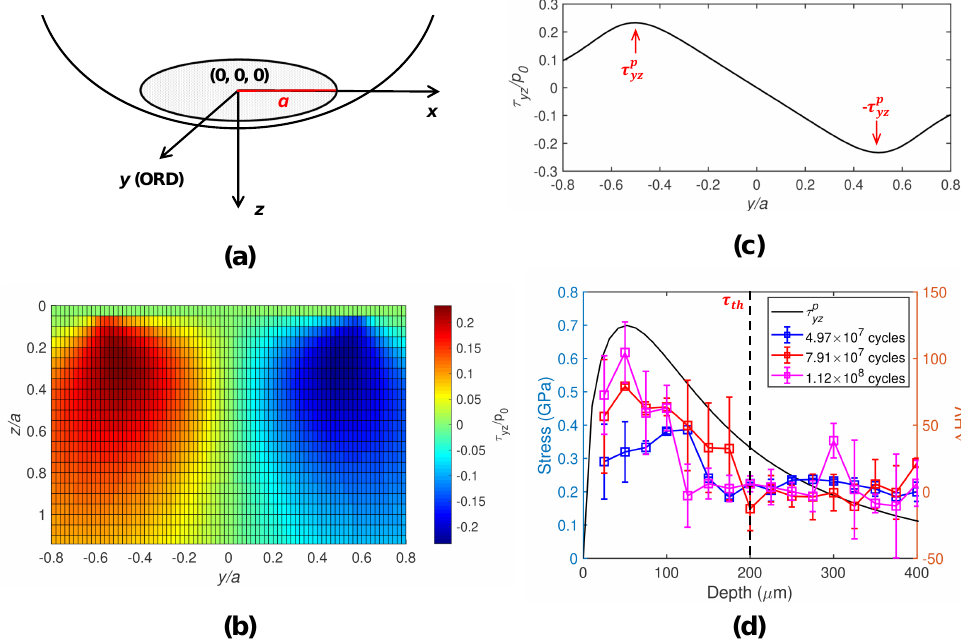
Figure 4. Stress state under Hertzian contact: ( a ) defined coordinate system for Hertzian contact; ( b ) distribution of τ yz in yz plane; ( c ) distribution of τ yz along y axis at z = 0.3 a ; ( d ) comparison between the evolving trend of τ p yz and the ∆ HV profiles at the